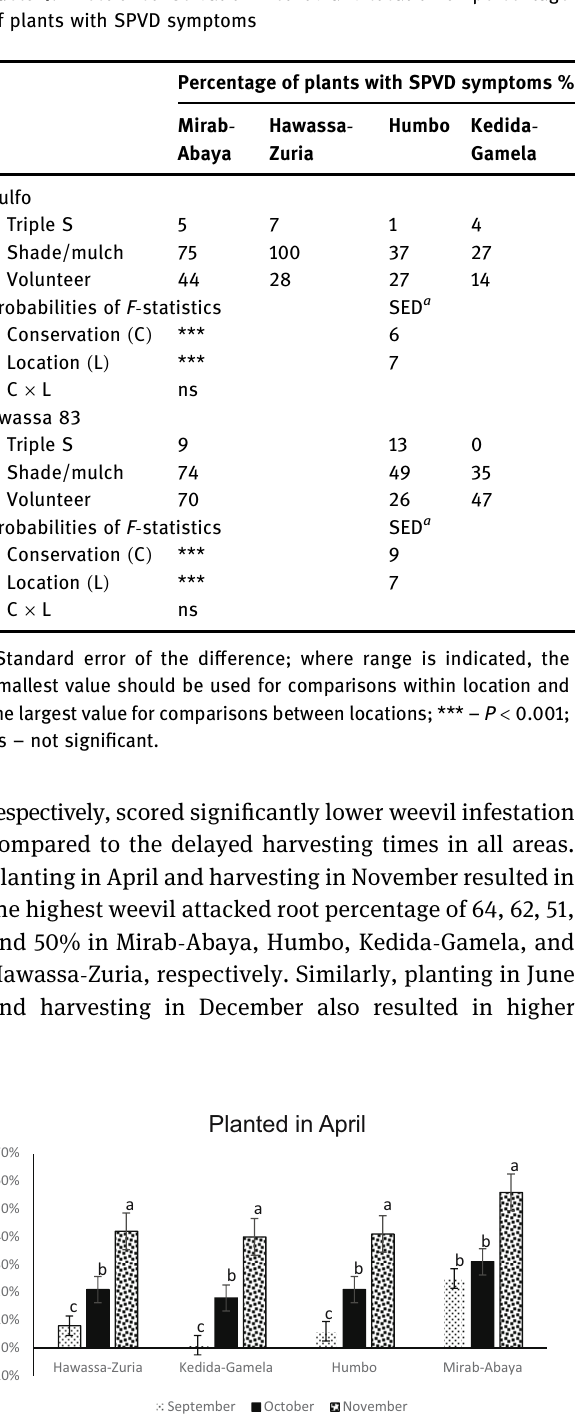
Figure 2: Percentage of weevil - infested roots for di ff erent harvest times in four districts in southern Ethiopia ( 2016 ) . Values with di ff erent letters di ff er signi fi cantly at P < 0.001.